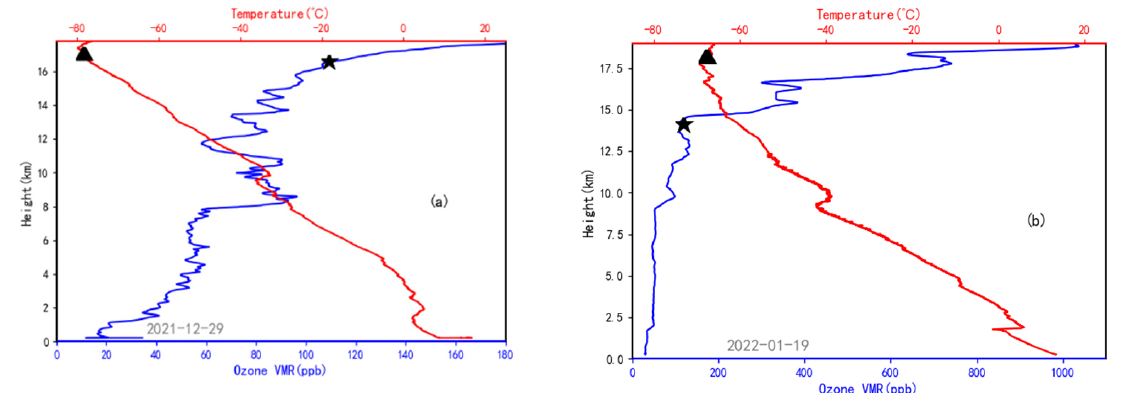
Figure 2. Profiles of tropospheric ozone VMR (blue lines) and temperature (red lines) at the Shaowu observation station. 29 December 2021 ( a ) and 19 January 2022 ( b ). The triangle sign indicates the location of the tropopause and the star sign indicates the starting point of the ozone surge layer.